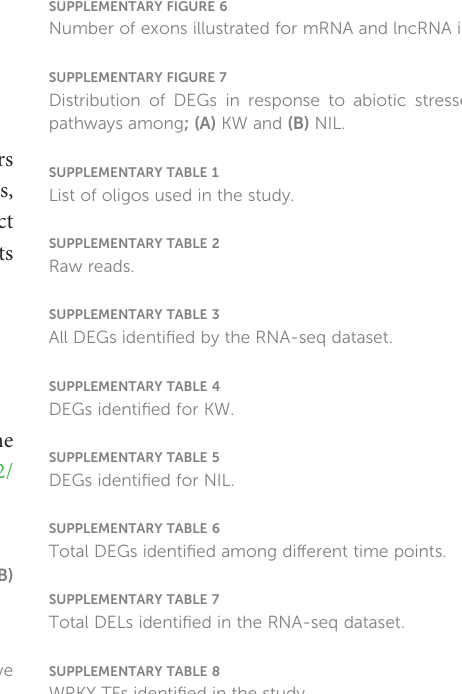
Number of exons illustrated for mRNA and lncRNA in RNA-seq dataset.